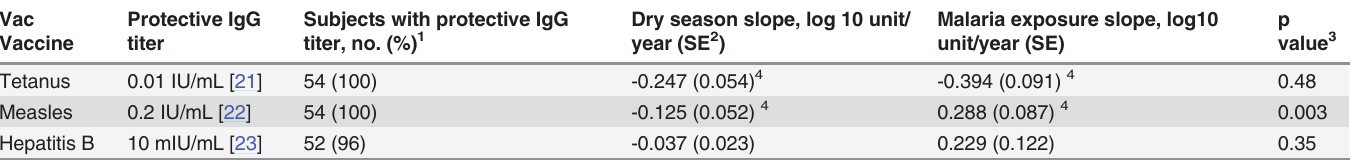
Table 2. Rate of change of vaccine-specific IgG levels during the dry season versus during malaria exposure and percentage of children with pro- tective IgG levels.